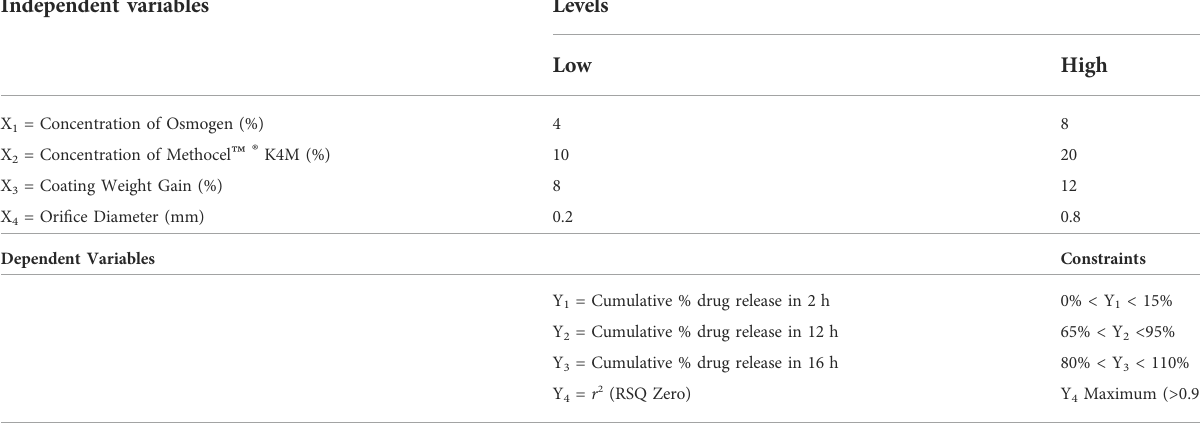
TABLE 1 Selection of factors, levels, and responses for 2 4 full factorial design. Independent